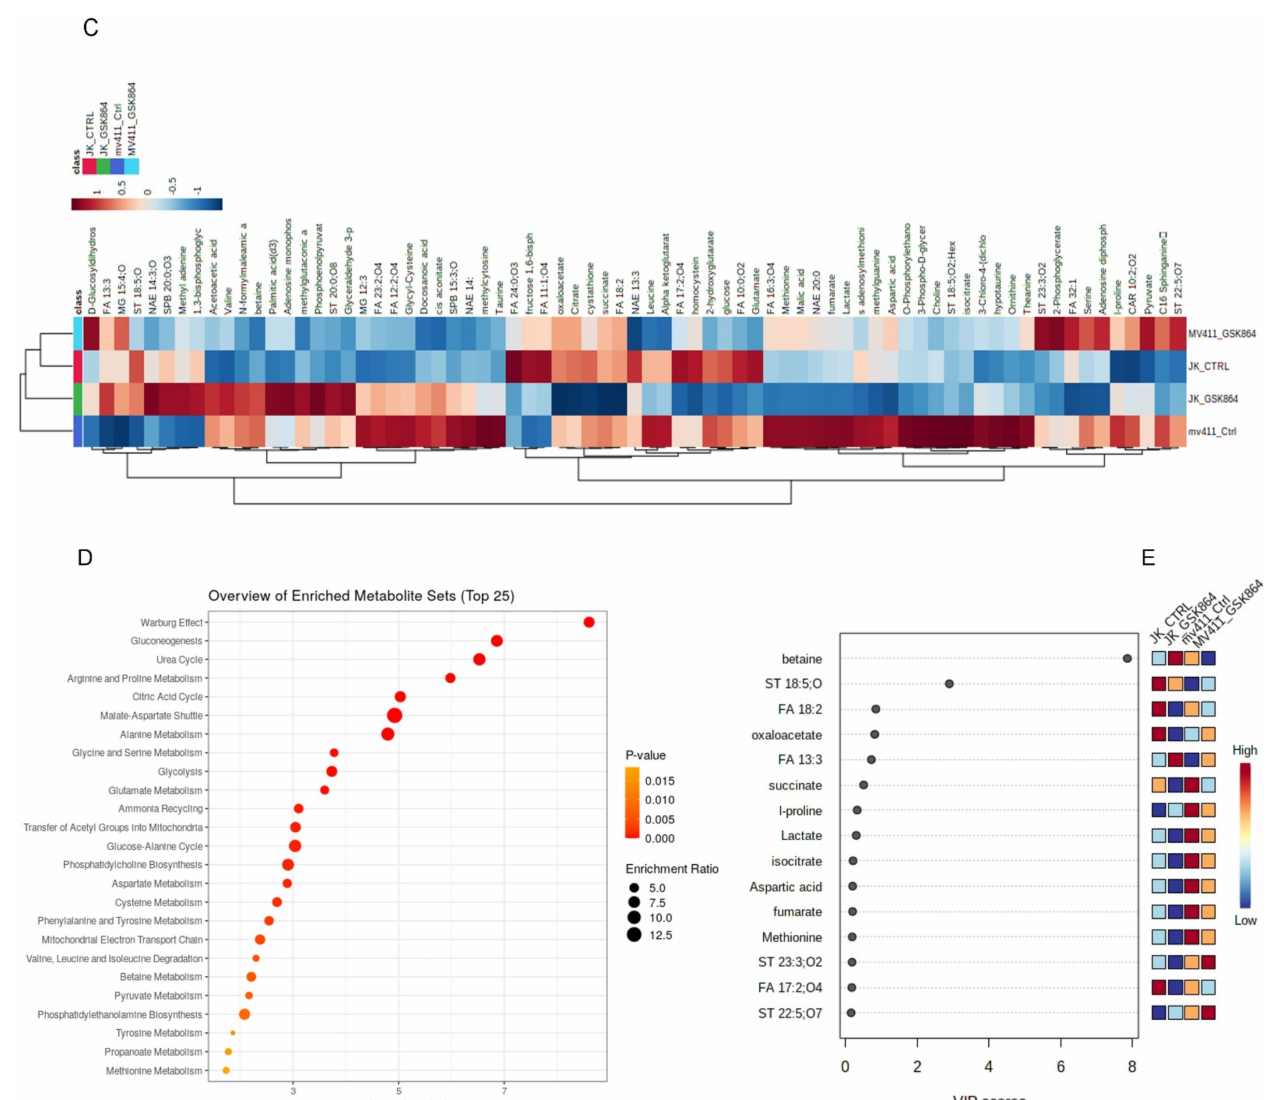
Figure 2. Metabolomic analysis of leukemic cells treated with IDHi: ( A ) PCA analysis of total metabolites of Jurkat and MV4 − 11cells; ( B , C ) correlation and expression heatmap of differential metabolites expressed in control and GSK864-treated cells; ( C ) top pathways enriched in Jurkat and MV4-11 control and GSK864-treated cells; ( D ) The enriched metabolic pathways altered by IDHi ( E ) VIP score for differentially expressed metabolites during GSK864